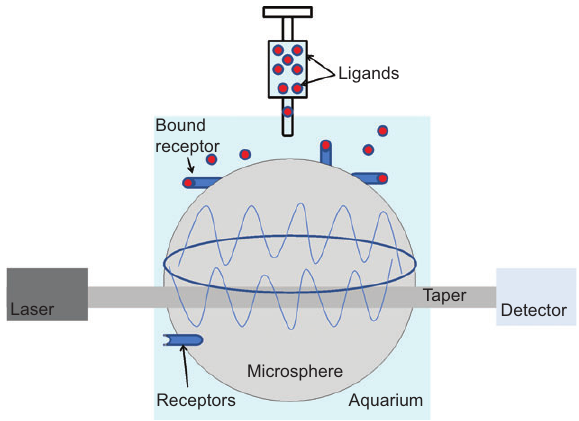
Figure 9 Scheme of WGM microsphere resonators. The micro- sphere and taper are encased in an aquarium, where protein can be pumped into the environment. The resonant frequency of the optical field shifts when protein binds to the immobilized ligand. This shift can be detected by the fiber taper.